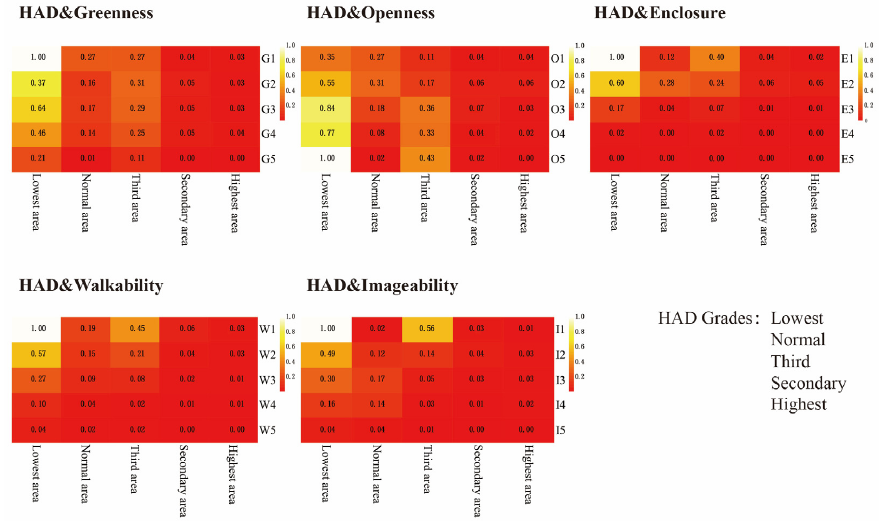
Figure 12. Heat map of human activity density and the five perceptions.